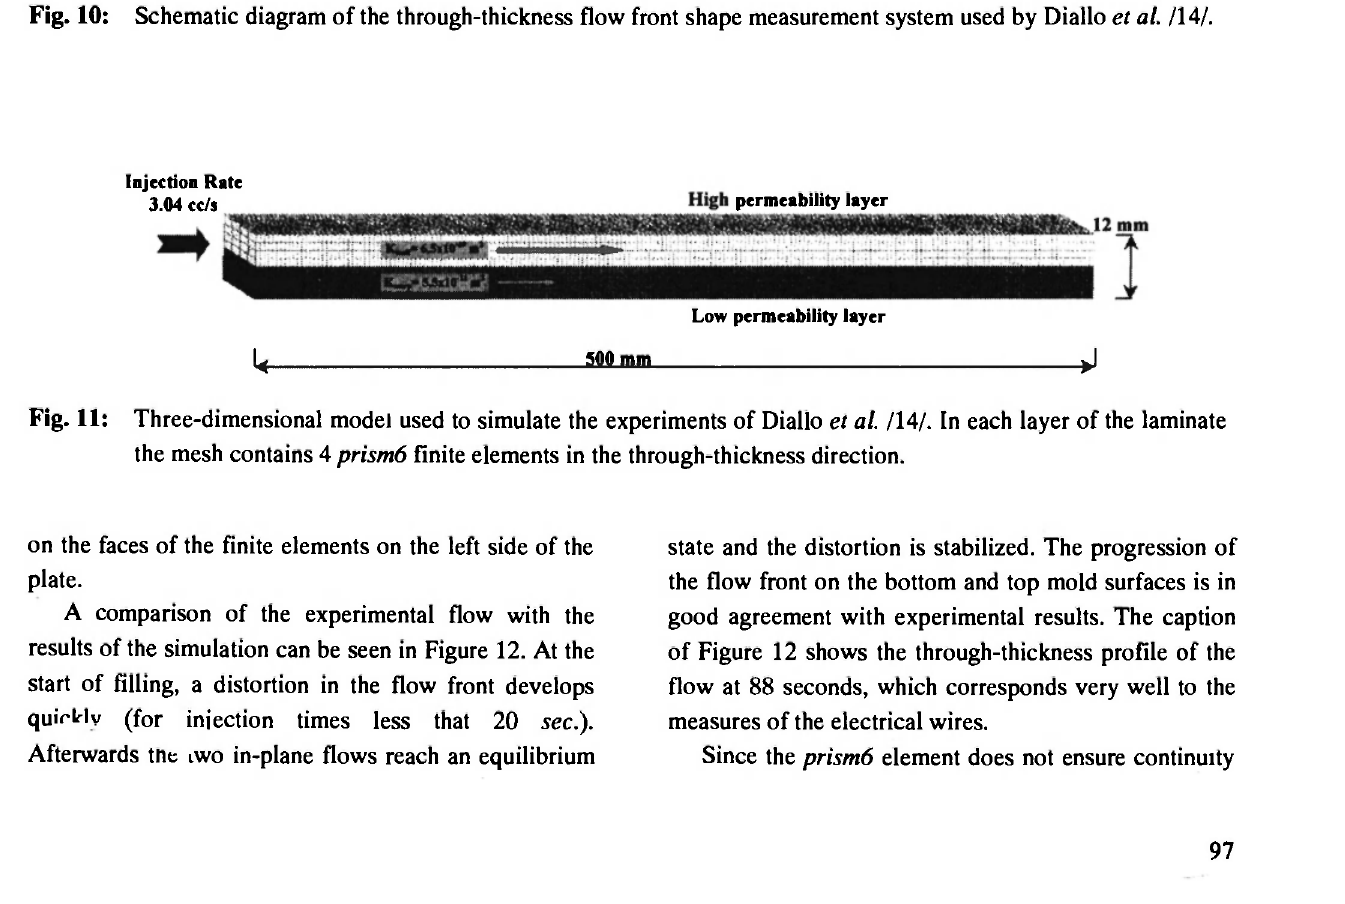
Schematic diagram of the through-thickness flow front shape measurement system used by Diallo et al. /14/.